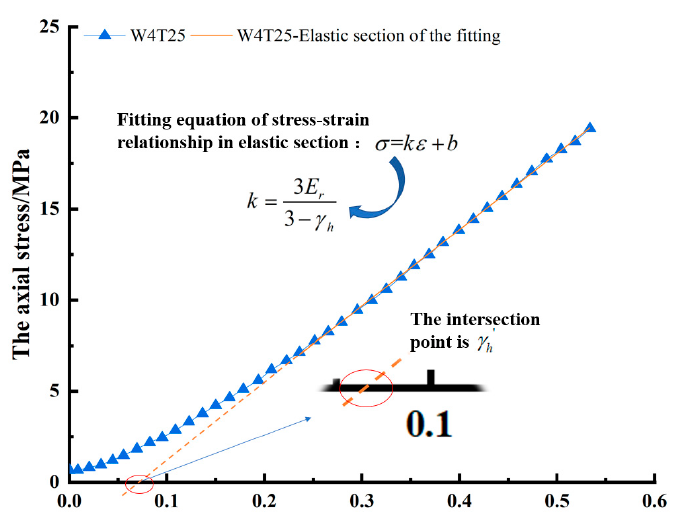
Figure 10. Relationship between model parameter solution and stress–strain curve.